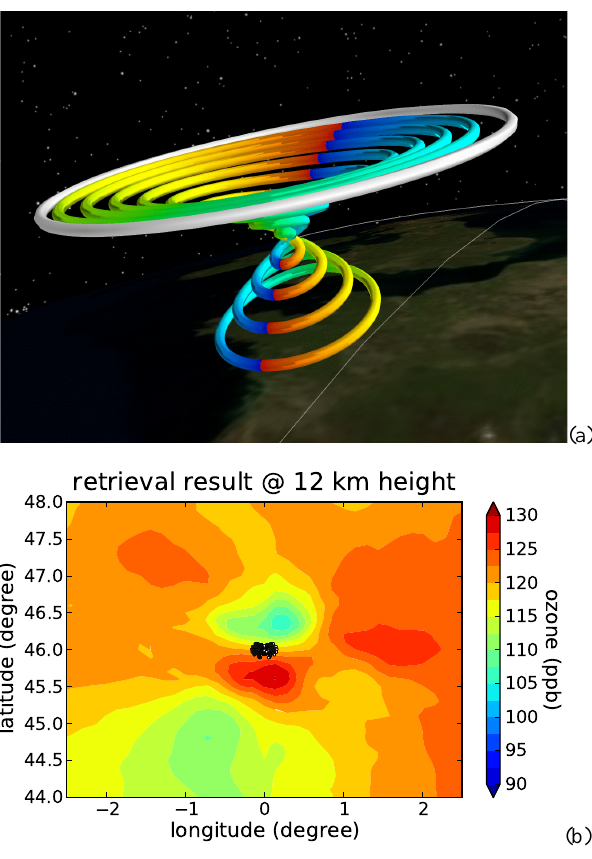
Fig. 9. This figure demonstrates a tomographic retrieval without panning. (a) Shows the location of the tangents of the measure- ments as color-coded spheres (red being the first measurements, blue the last ones) and the flight-track as white tube. (b) Shows the retrieval result at 12km